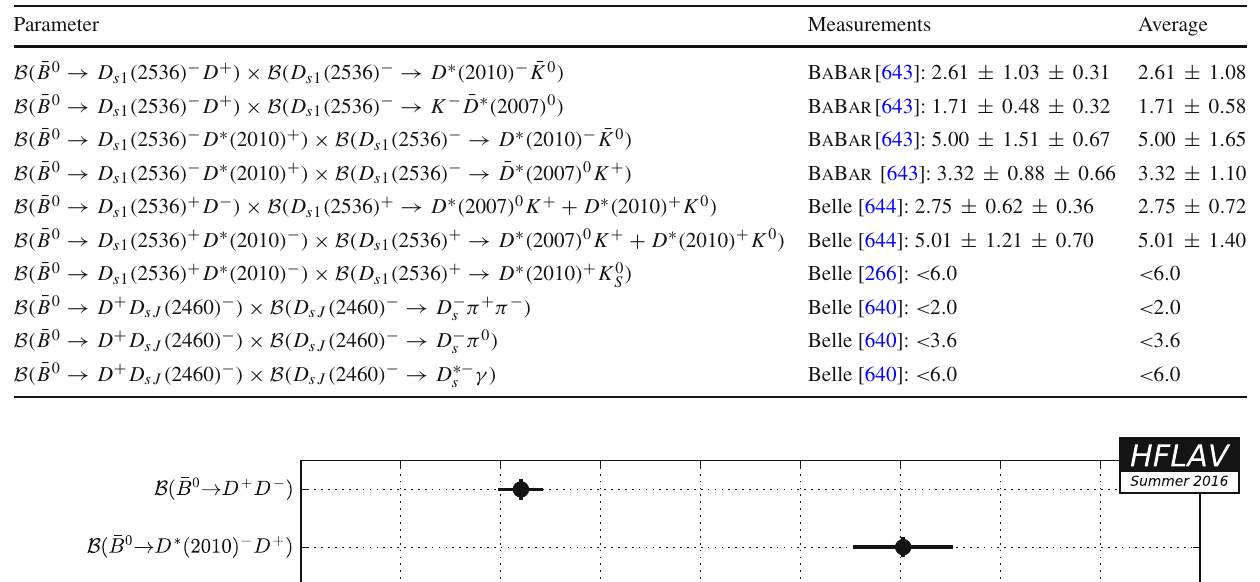
Table 115 Product decay rates to excited D s mesons II [ 10 − 4 ]